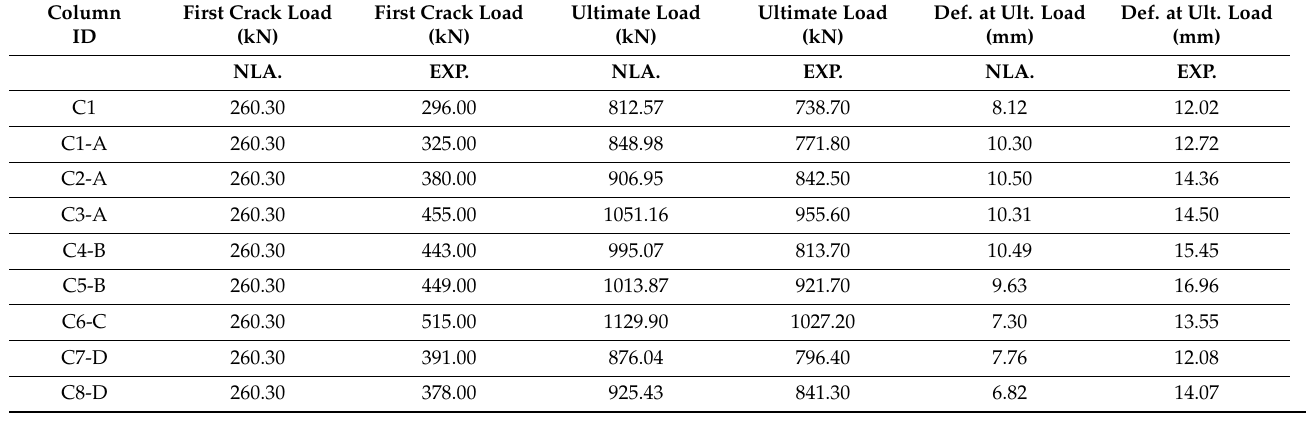
Figure 19. Comparison between Exp. and NLA ultimate loads. Table 9. Experimental and analytical results.